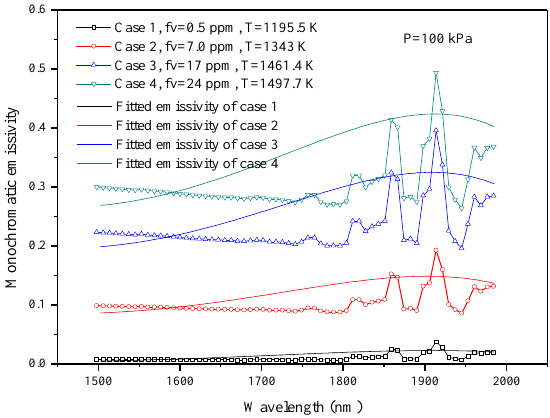
Figure 12. Reconstruction of soot volume fractions of four cases by monochromatic emissivity.